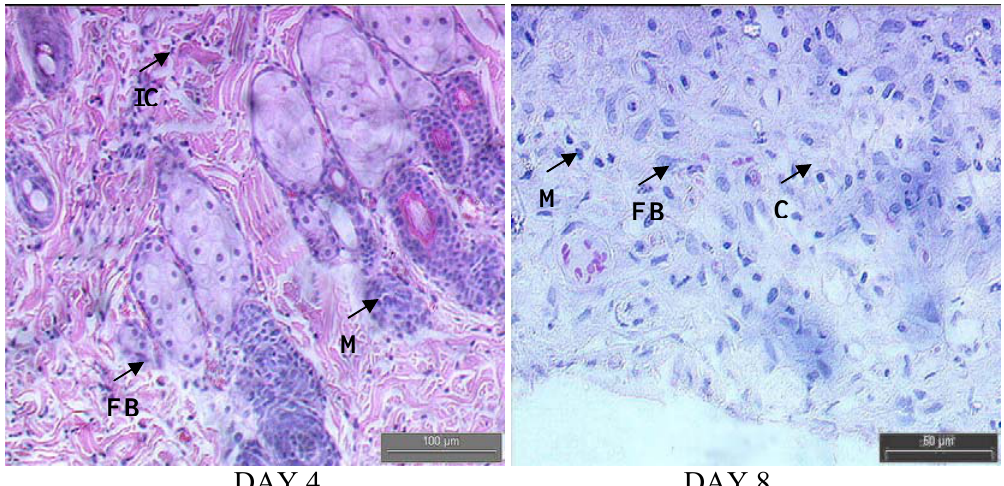
Figure 5. Hematoxylin and eosin stained sections of the granulation tissue in treated group at different time intervals. Fibroblasts (FB), macrophages (M), collagen (C) bundles, Vascularization with larger blood vessels (BV) and inflammatory cells